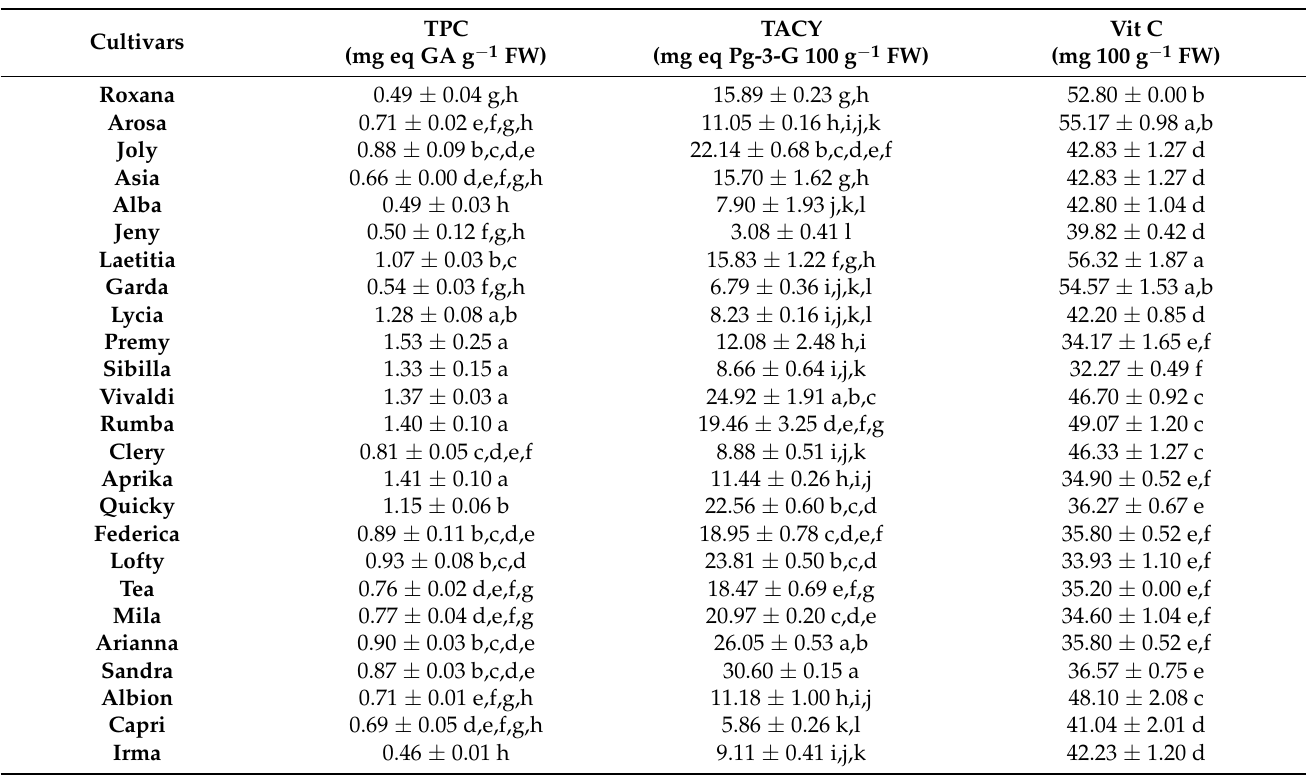
Table 1. Table 1. Total phenolic (TPC), anthocyanin (TACY), and vitamin C (Vit C) content in strawberry fruit